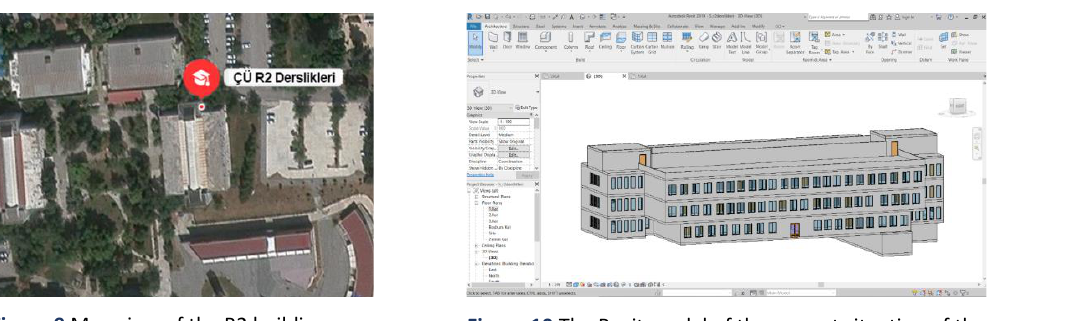
Figure 9 Map view of the R2 building Figure 10 The Revit model of the current situation of the R2 building